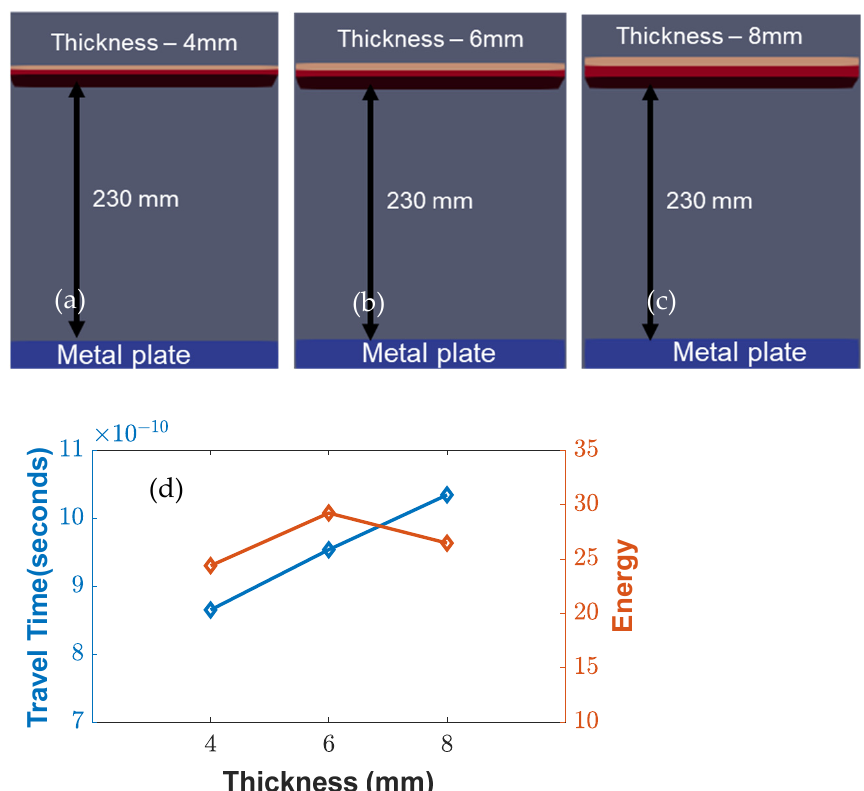
Figure 5. ( a ) Simulation setup for variable dielectric constants (3–15) considering a high-density polyethylene plate below the sensors, and ( b ) parametric study of various dielectric constants with similar travel times and energies.